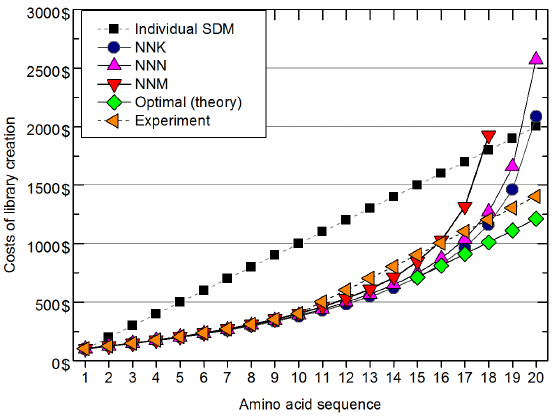
Figure 3. Comparison of projected costs of randomized codon- based saturation mutagenesis library creation and one-by-one site-directed mutagenesis (SDM). Empirically determined results for the combined b -glucosidase Zm-p60.1 mutagenesis approach are also shown (experimental).